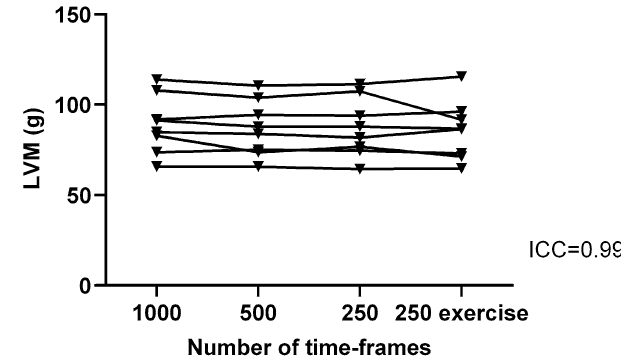
Figure 2. Reliability of left ventricular mass (LMV) measurements between real-time image stacks constructed from different numbers of time-frames at rest and during exercise in eight healthy volunteers. Reliability was high between measurements of left ventricular mass in real-time short-axis image stacks originating from 1000, 500, and 250 time-frames at end expiration. Real-time image stacks originating from 1000, 500 and 250 time-frames correspond to image acquisition times of ~ 34, ~ 17 and ~ 8 s respectively. The lines between the different time-frame measurements indicate the same research participants in the groups. 250 exercise shows measurements from images acquired during on-going exercise. ICC intraclass correlation